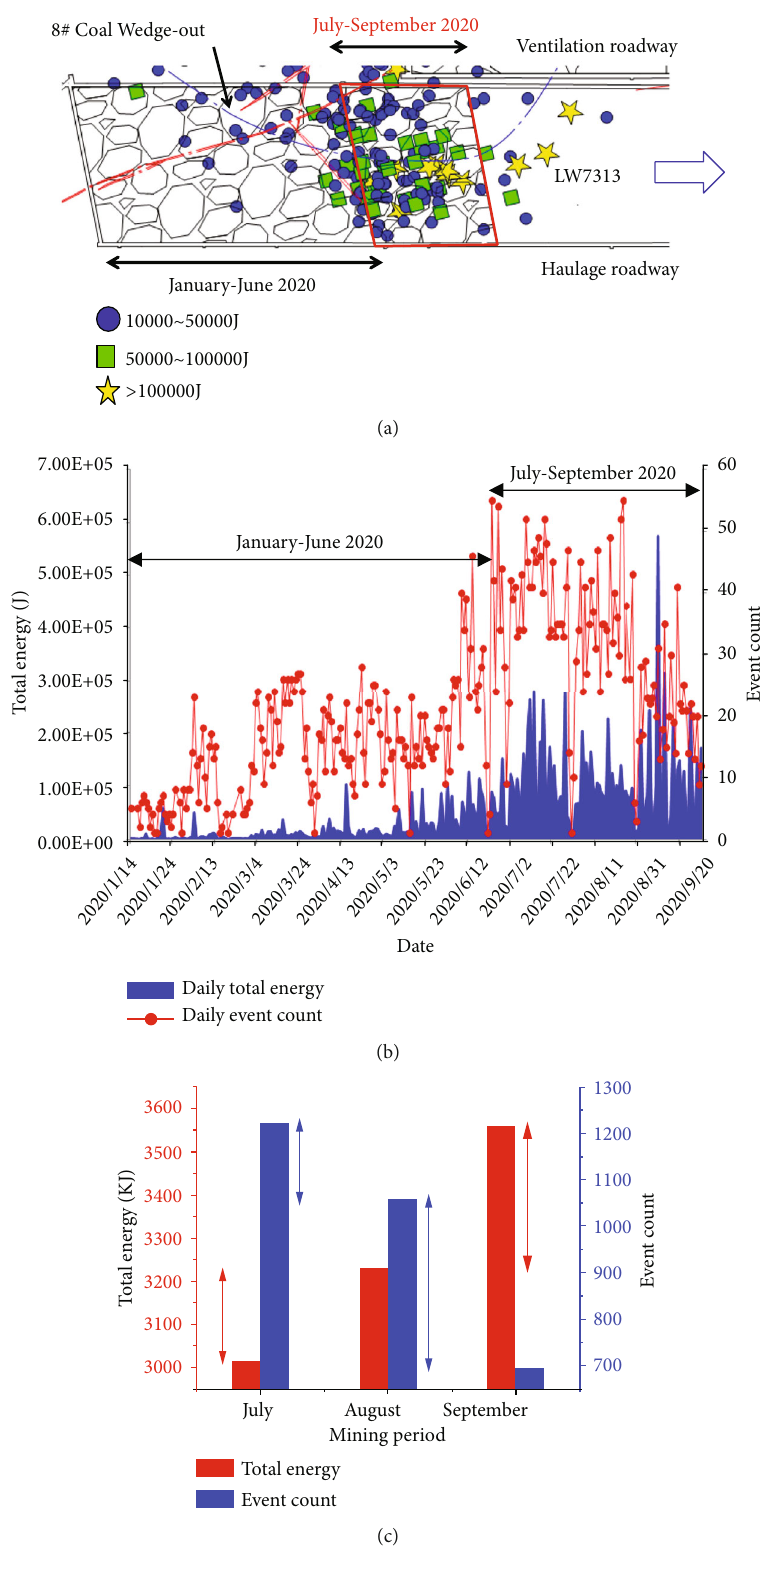
Figure 2: Distribution map of microseismic activity: (a) localization plan of microseismic events ( energy > 10 4 J); (b) microseismic frequency and energy distribution map; (c) trend graph of microseismic